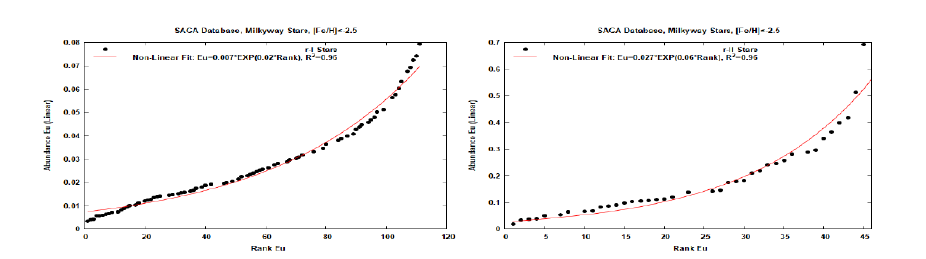
Figure 5. Rank tests for Eu abundances in r-I and r-II stars separately. For Eu a further nucleosynthesis source is required in addition to the two di ff erent strong sources dominating Th in r-I and r-II stars. This indicates that Eu from a weak r-process event (dominating limited-r stars) contributes as well.